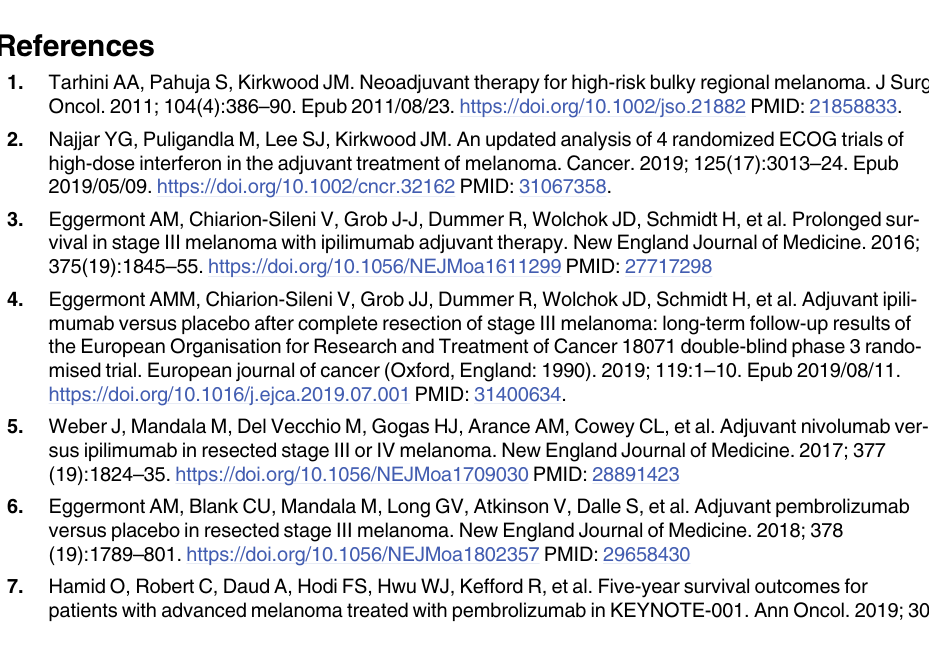
S1 Table. Genes analyzed in PanCancer immune profiling, PanCancer pathways, PanCan- cer progression, and custom panels. S2 Table. Patient demographics and baseline disease characteristics of patients enrolled in clinical trial (N = 30